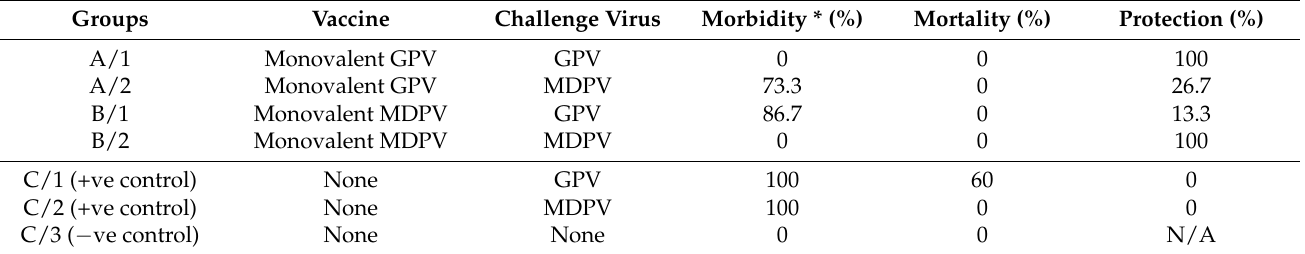
Table 4. Cross-protection between GPV and MDPV in MDA-free Muscovy ducks: Clinical protection against